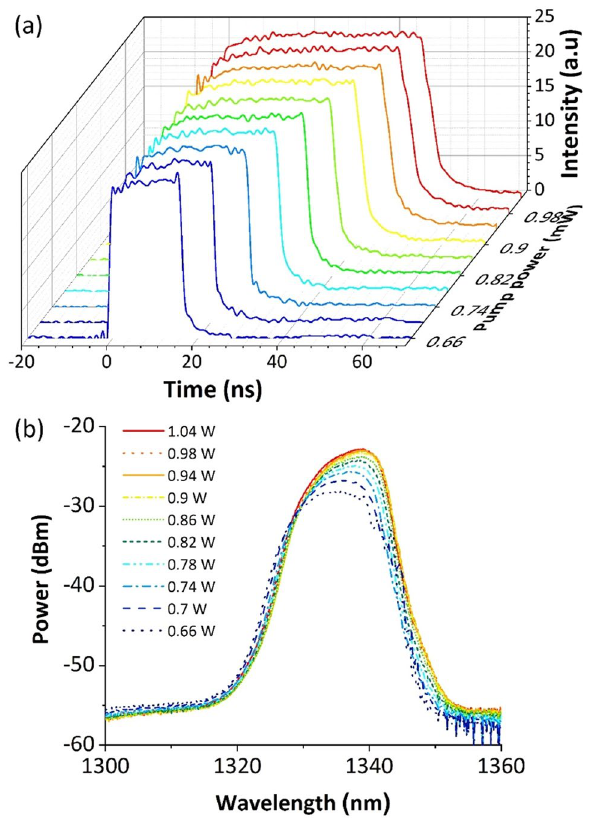
Figure 3. (a) Single-pulse envelope as the pump power increases and (b) the corresponding optical